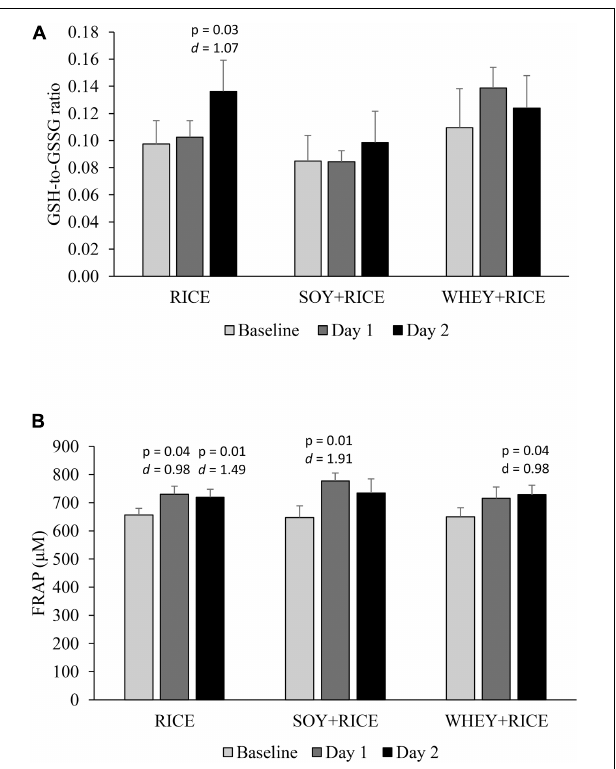
FIGURE 5 | Post-exercise antioxidant capacity ( n = 7). Plasma reduced-to-oxidized glutathione (GSH-to-GSSG ratio) (A) and FRAP (B) , measured 1 h post-exercise, are similar for the three supplemented trials on the baseline, Day 1 and Day 2. Marginal time effect was found for FRAP but not for GSH-to-GSSG ratio (B) . RICE alone drink (carbohydrate 95%, protein 4%, and fat 1%), SOY-RICE drink (carbohydrate 82%, protein 10%, and fat 8%), and WHEY-RICE drink (carbohydrate 76%, protein 20%, and fat 4%) in